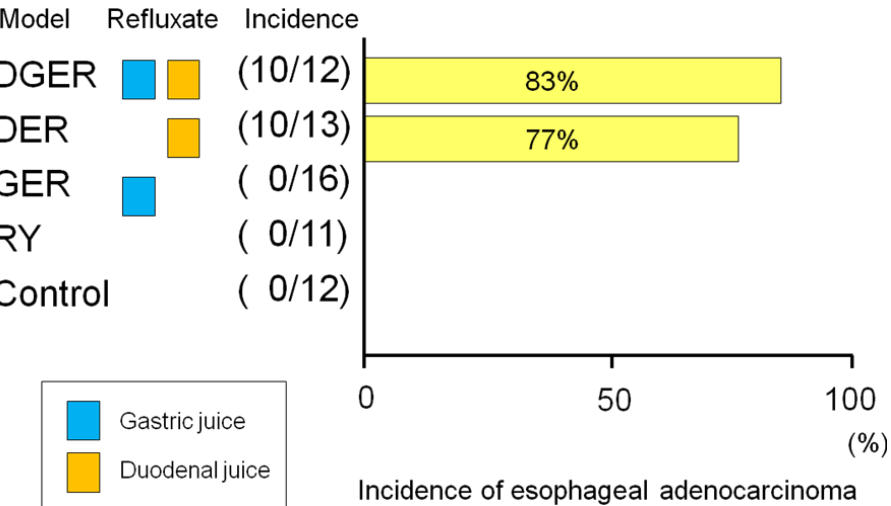
Figure 3. The incidence of esophageal adenocarcinoma in the DGER or the DGR was significantly higher than in the GER or the RY (p < 0.001). Esophageal adenocarcinoma developed only in models with refluxate including duodenal juice. No exogenous carcinogen was administered in this experiment.